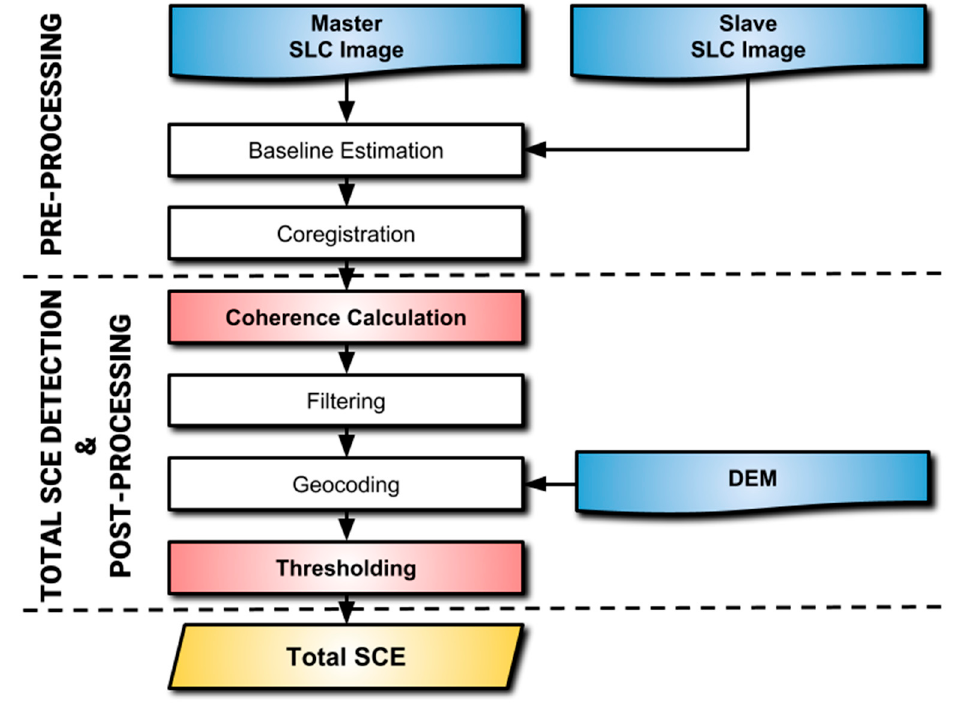
Figure 7. The overall workflow of interferometric SAR (InSAR)-based algorithms to detect total snow cover. Master and slave image refer to the two single look complex (SLC) SAR images used to generate an InSAR pair.